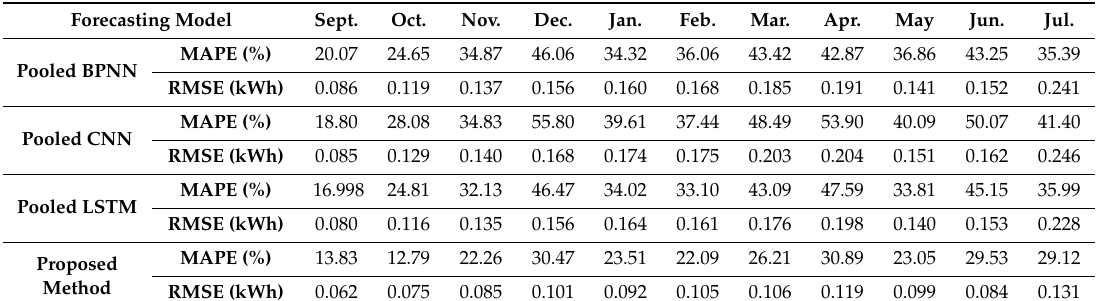
Table 6. Monthly-average of MAPE for the higher uncertain